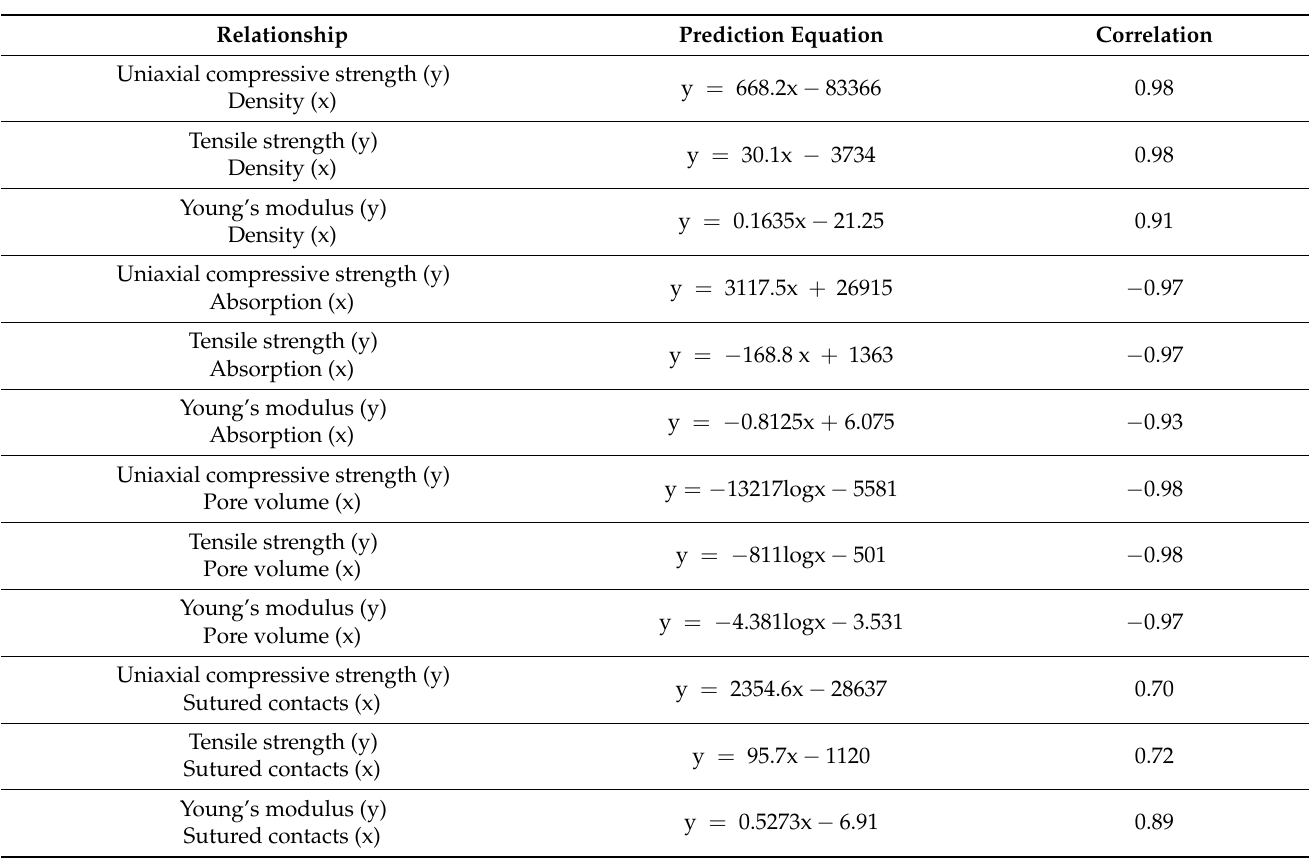
Table 15. Regression equations for the prediction of geomechanical properties [5] (uniaxial compres- sive strength in psi, density in pcf, tensile strength in psi, Young’s modulus × 10 6 in psi, absorption in %, total pore volume in cc/gm, sutured contacts in %). Prediction Equation